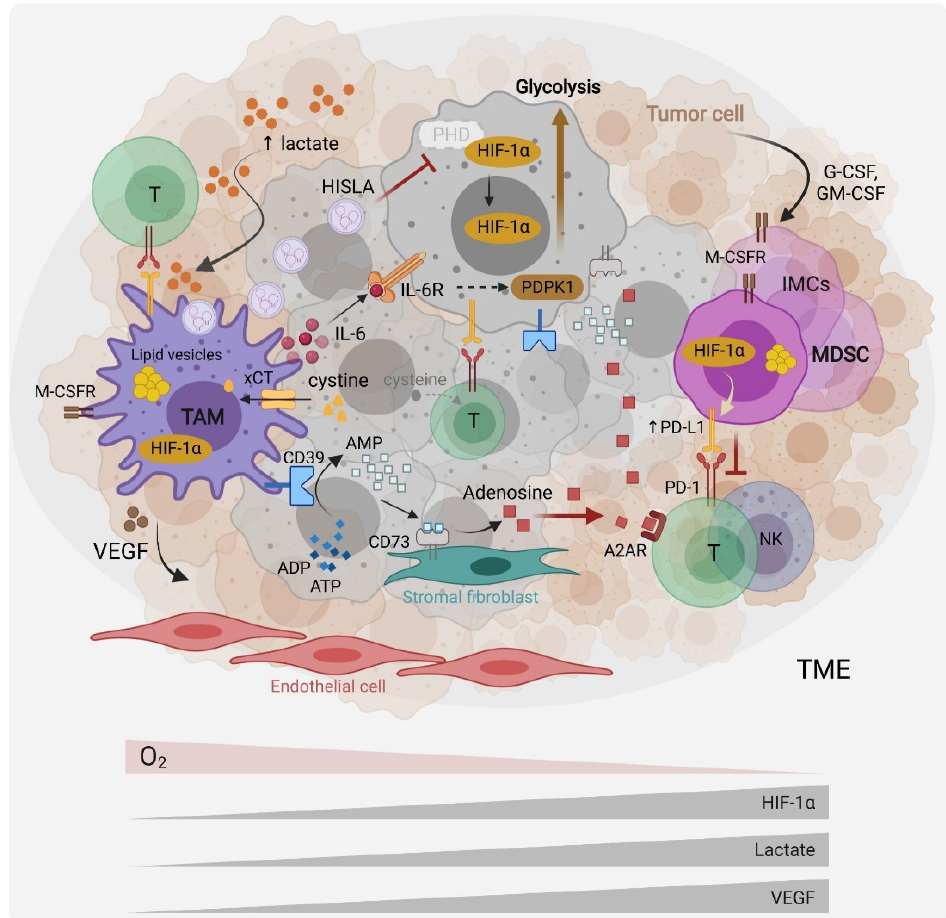
Figure 1. Myeloid cells metabolic interactions with other cells in the tumor microenvironment. Tumor cells produce G-CSF and GM-CSF that recruit myeloid cells, including immature myeloid cells (IMC), myeloid-derived suppressor cells (MDSCs) and tumor-associated macrophages (TAMs) to the TME. Hypoxia, which results in the stabilization of the hypoxia-induced factor (HIF)-1a, the tumor cell’s upregulation of aerobic glycolysis (the Warburg effect), and subsequent TME lactate accumulation and acidification, modulate myeloid cells towards pro-tumoral and immunosuppressive effectors. Through the expression of cytokines such as interleukin (IL)-6, immune checkpoints ligands such as Programmed Death Ligand 1 (PD-L1), and growth factors such as Vascular Endothelial Growth Factor (VEGF), myeloid cells promote tumor-cell survival, immune evasion and angiogenesis. Recently, TAMs were reported to promote the Warburg effect via IL-6 signaling as well as through vesicles containing a HIF-1a-stabilizing lncRNA (HISLA). Through the cystine transporter xCT, MDSCs and TAMs deplete the TME of cysteine, which is necessary for T cell effector functions. They further suppress T cell activity by upregulating the expression of the ectonucleotidases CD39 and CD73 at their surface, leading to adenosine production and immunosuppressive signaling via the adenosine receptor (A2AR). TAMs and MDSCs accumulate lipid droplets in cytosolic vesicles and appear to rely on lipid metabolism and fatty acid oxidation for their pro-tumoral